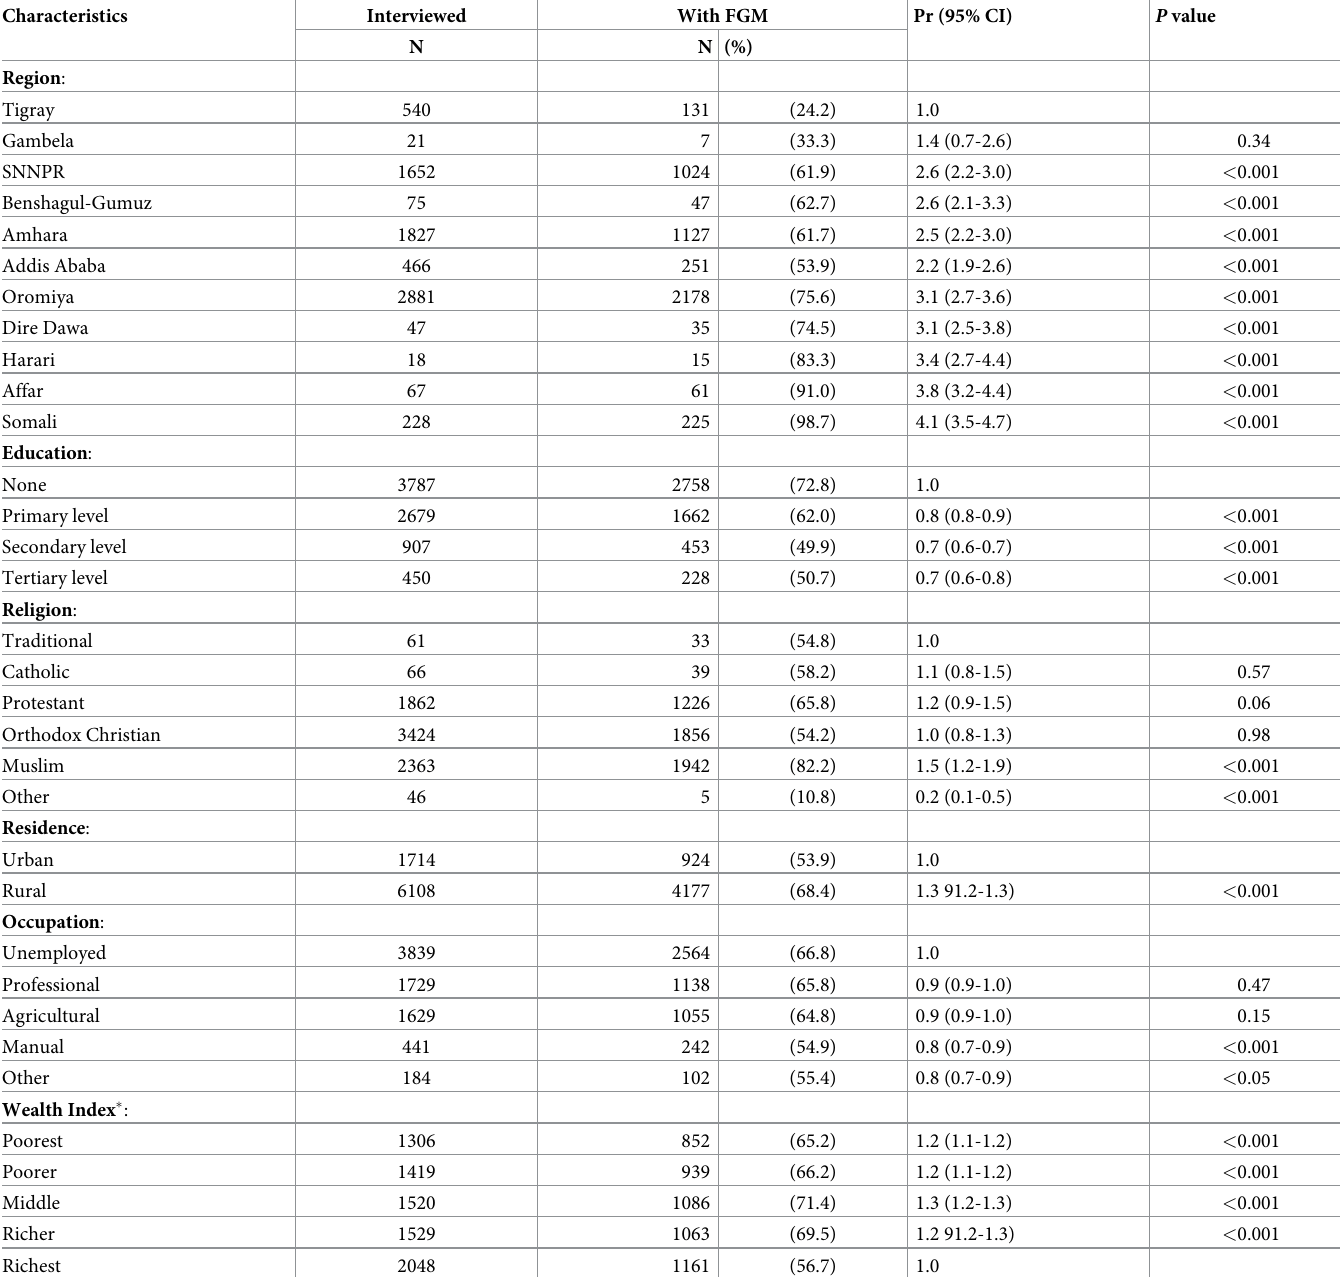
Table 5. Factors associated with female genital mutilation (FGM) in Ethiopia: 2016.